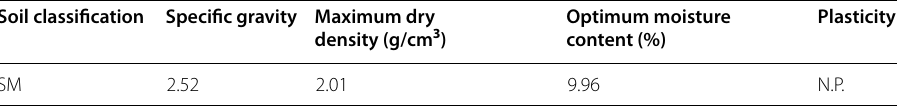
Table 1 Index properties of the soil sample